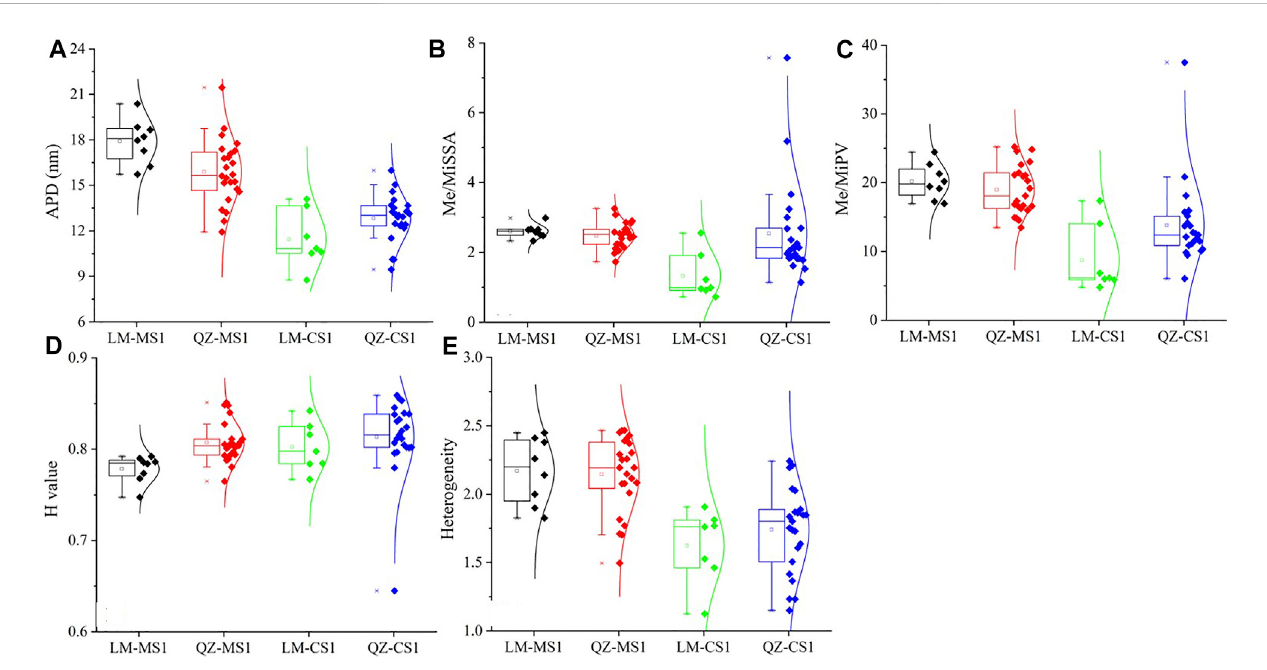
FIGURE 3 Comparison of pore structural parameters including (A) APD, (B) Me/MiSSA, (C) Me/MiPV, (D) H value and (E) Heterogeneity of shale